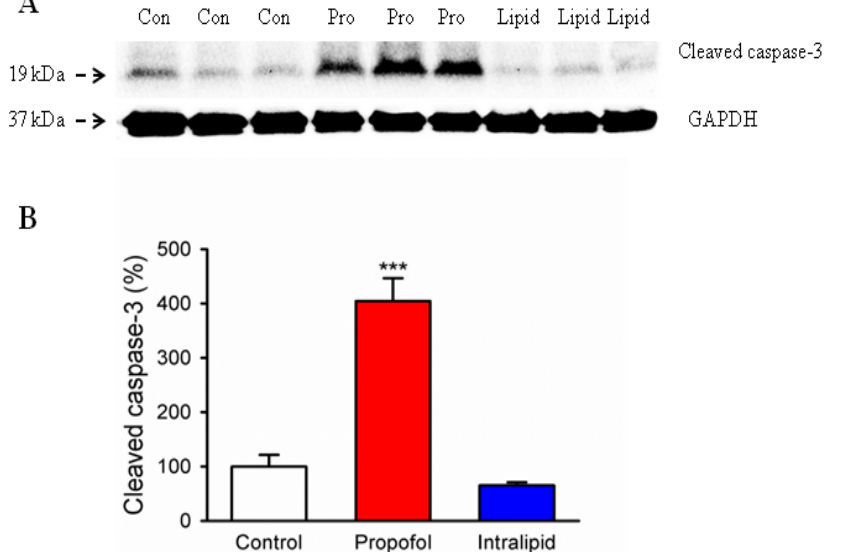
Figure 2. Prenatal propofol exposure induced caspase-3 activation in the brain tissues of fetal rats. A 2 h IV infusion of Propofol (Pro), intralipid (Lipid) or saline control (Con) was administered to pregnant rats on G18 ( N = 3 dams per group). Fetuses were removed via C-section at six hours post infusion. Whole cerebral hemispheres of fetal rats were harvested and analyzed by Western blot. ( A ) Propofol infusion induced significantly higher caspase-3 activation in the brain tissues of fetal rats as compared to the control condition or intralipid infusion with Western blot analysis. There is no statistically significant difference in the amounts of GAPDH in the rat brain tissues following the propofol, intralipid treatment or control condition. ( B ) Quantification of the Western blot shows that propofol anesthesia increased cleaved caspase-3 levels in the rat brain tissues compared to the control groups (*** p < 0.001). Intralipid infusion did not affect the levels of cleaved caspase-3 in the brain of fetal rats. Data from six pups (2 pups from 3 litters) per group are expressed as means ±